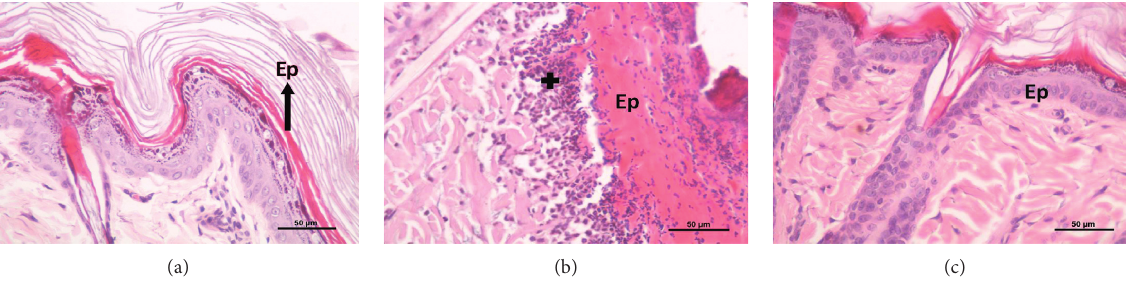
Figure 7: H&E staining of control skin of the rat (a) showed 3–4 layers of keratinized stratified squamous cells with normally appearing keratin layer epidermis (Ep). Formalin exposed rat skin (b) showed thickened degenerated epidermis (Ep) and inflammatory cells infiltrate (+), and LUL-NEG (c) exposed rat skin revealed no abnormal changes in the treated rat skin tissue as compared to controls